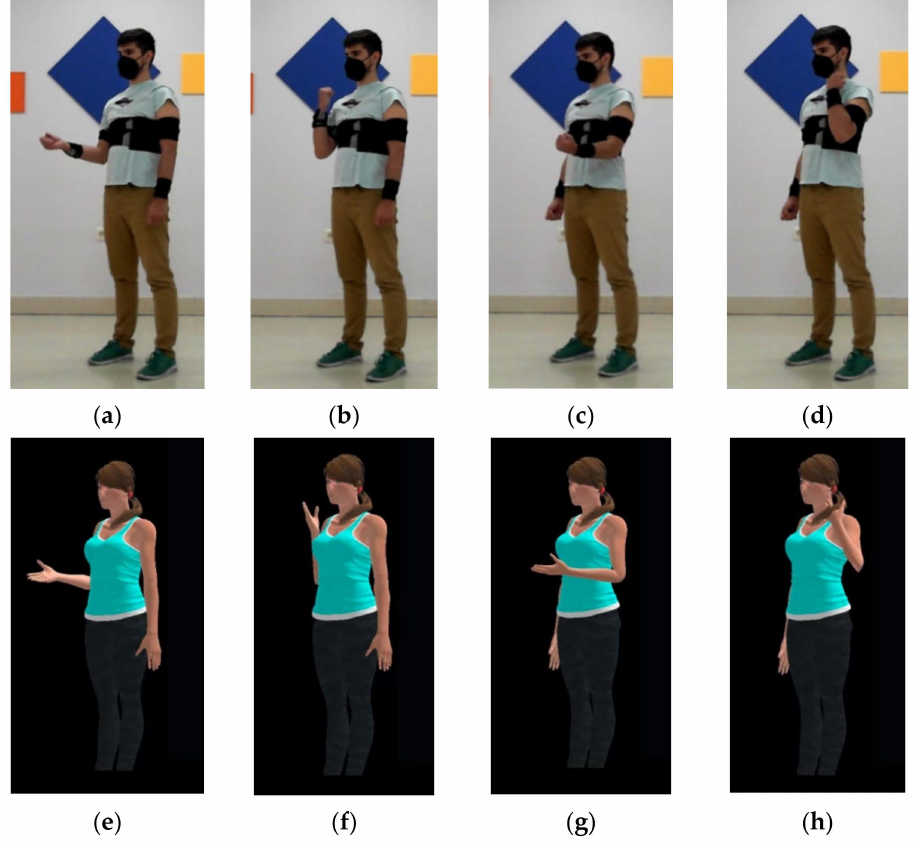
Figure 8. Real elbow joint instantaneous poses: ( a ) Right Elbow 90 degrees; ( b ) Right Elbow 145 degrees ( c ) Left Elbow 90 degrees; ( d ) Left Elbow 145 degrees. Corresponding poses reconstruction of real elbow joint experiment on a 3D avatar: ( e ) Right Elbow 90 degrees; ( f ) Right Elbow 145 degrees ( g ) Left Elbow 90 degrees; ( h ) Left Elbow 145 degrees.